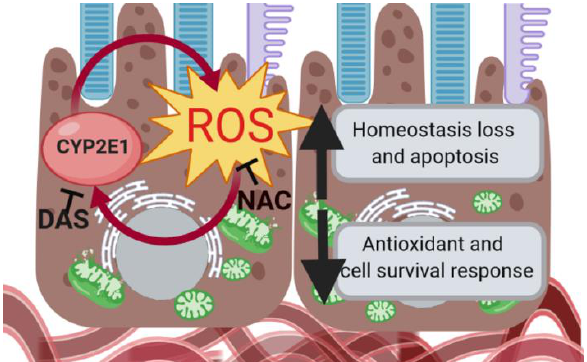
Figure 7. CYP2E1 induces oxidative stress in retinal pigment epithelium (RPE) cells promoting outer-blood retinal barrier degeneration. Low levels of ROS in RPE cells activates their antioxidant response and cell survival pathways. In contrast, the activation of CYP2E1 by accumulation of ROS induces its own regulation, increasing oxidative stress which results in cell death and finally RPE dysfunction. Created by BioRender.com.